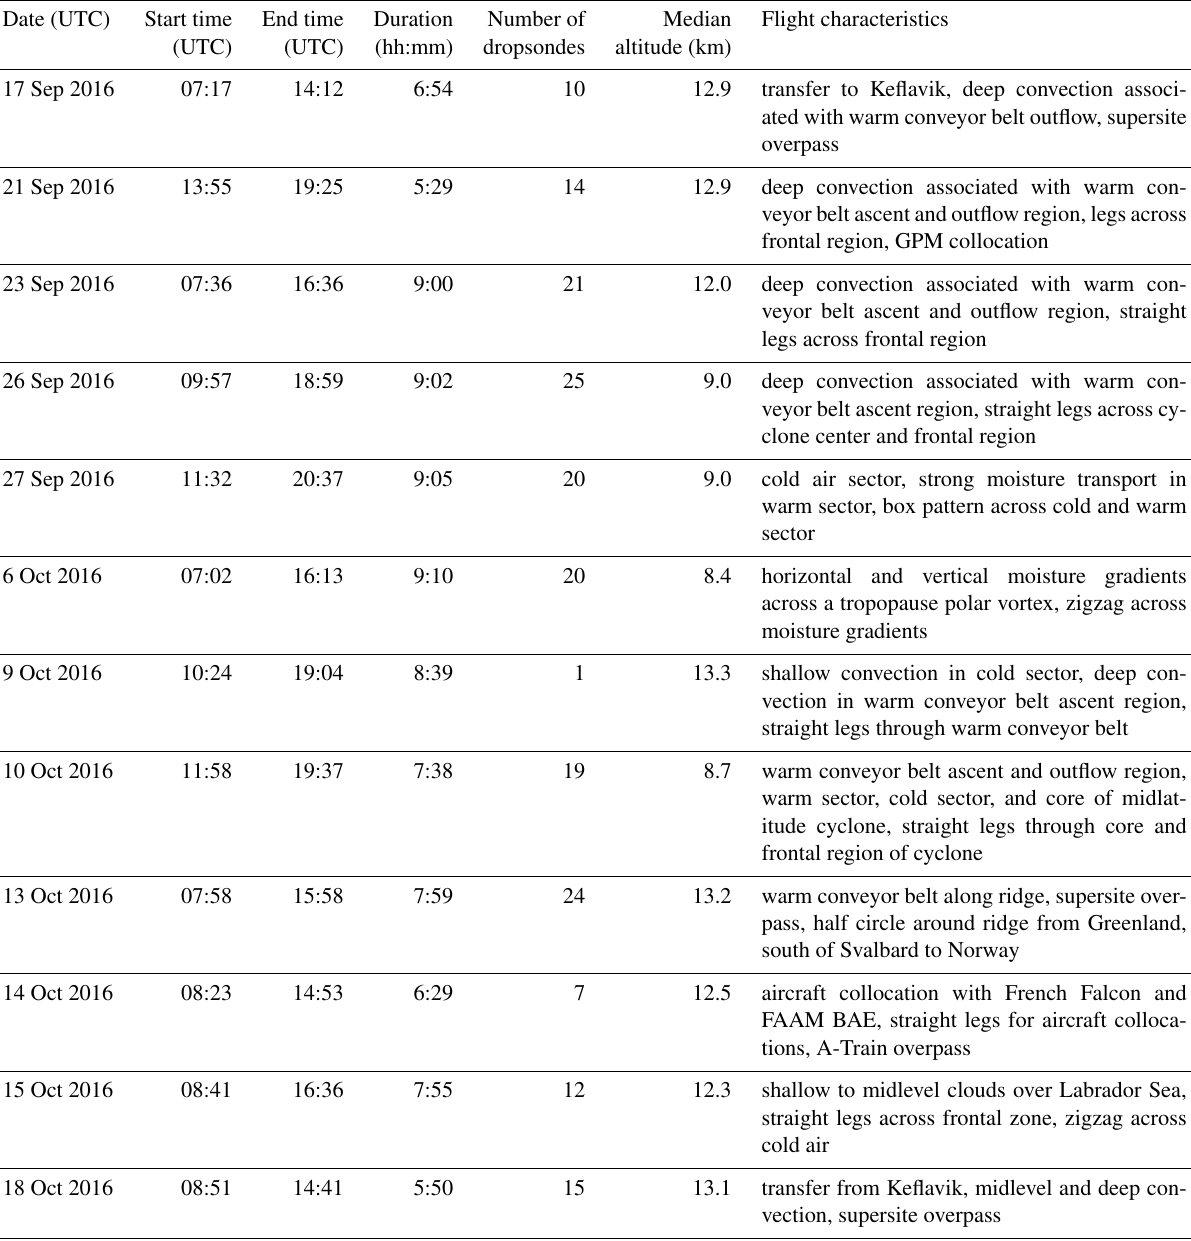
Table 4. List of NAWDEX